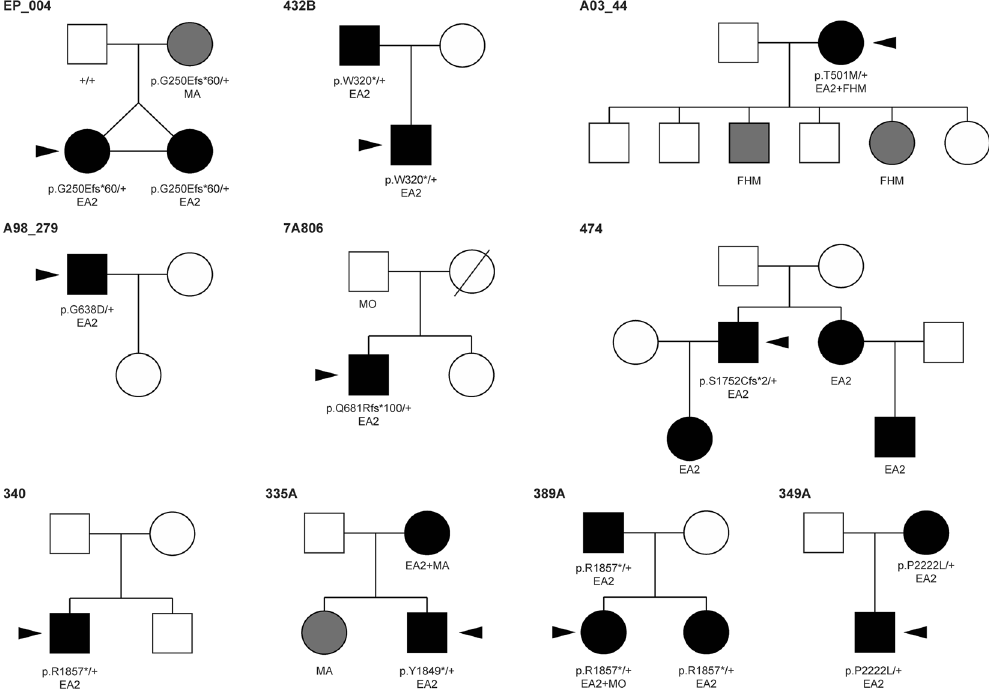
Figure 2. Pedigrees from individuals with identified changes. The code on top of every pedigree corresponds to the proband individual, indicated by a black arrow. Affected individuals are denoted by solid symbols; episodic ataxia is indicated in black and other phenotypes in gray; squares indicate males and circles indicate females. Clinical characteristics are indicated below each individual (EA2: episodic ataxia type 2; FHM: familial hemiplegic migraine; MO: migraine without aura; MA: migraine with aura). Gene variant carrier status is indicated below individuals. A complete screening of the CACNA1A gene was performed by Sanger sequencing and CNV analysis only in the probands (indicated by an arrow), whereas in the other family members where the genotype is indicated, only the variant identified in the proband was tested. In those individuals where the genotype is not shown, DNA was not available for